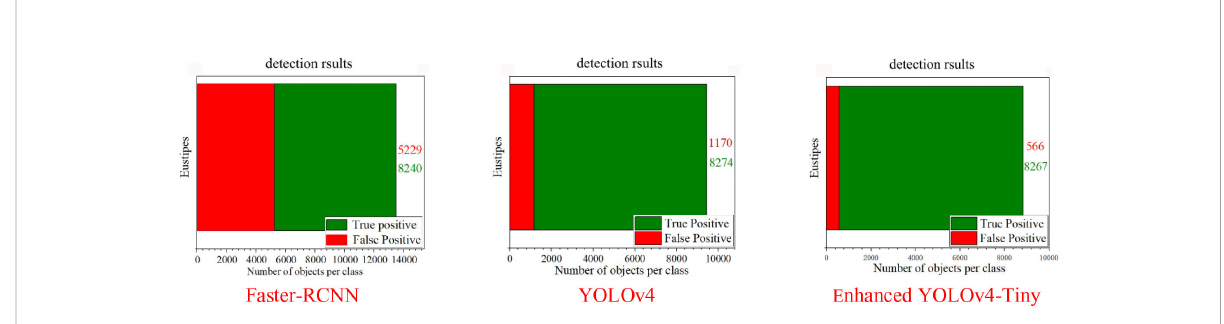
FIGURE 10 Identi fi cation and detection effect of sugarcane stem segment under different